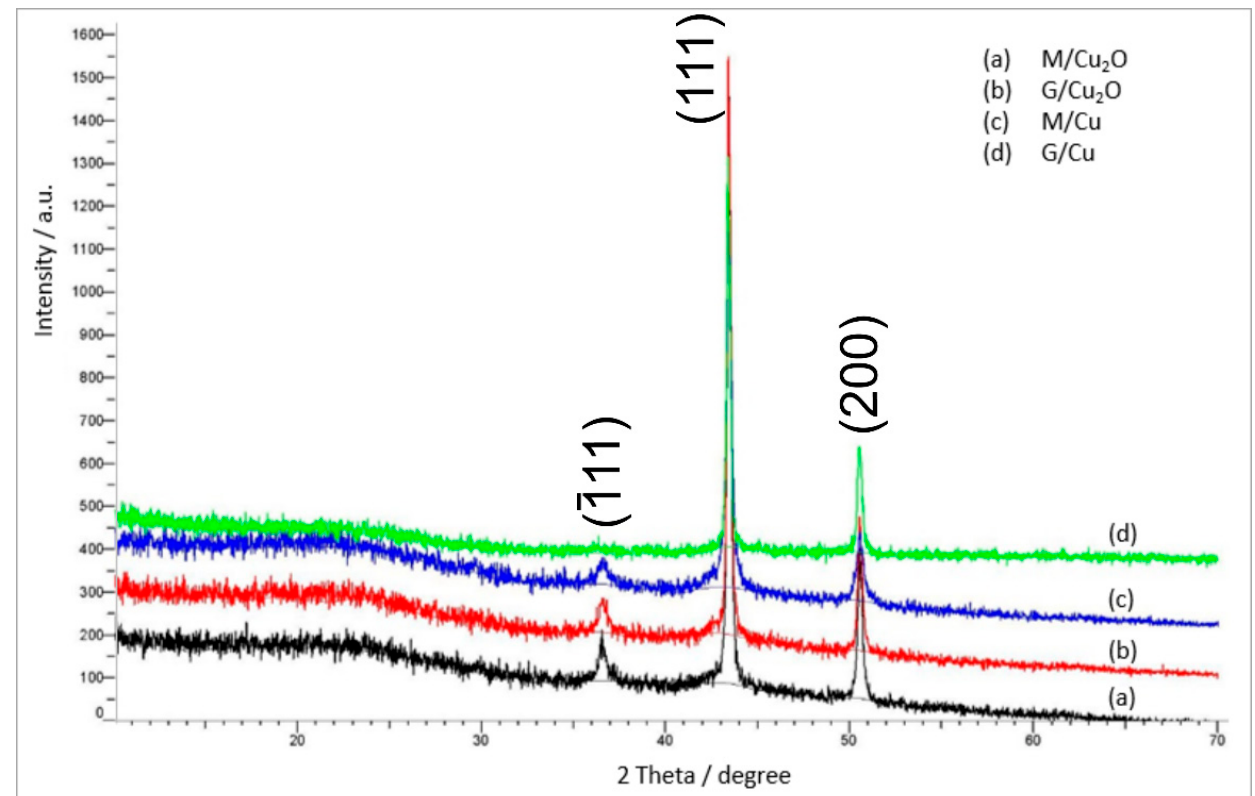
Figure 6. XRD patterns of the residues in N 2 of ( a ) M/Cu 2 O, ( b ) G/Cu 2 O, ( c ) M/Cu, ( d ) G/Cu.